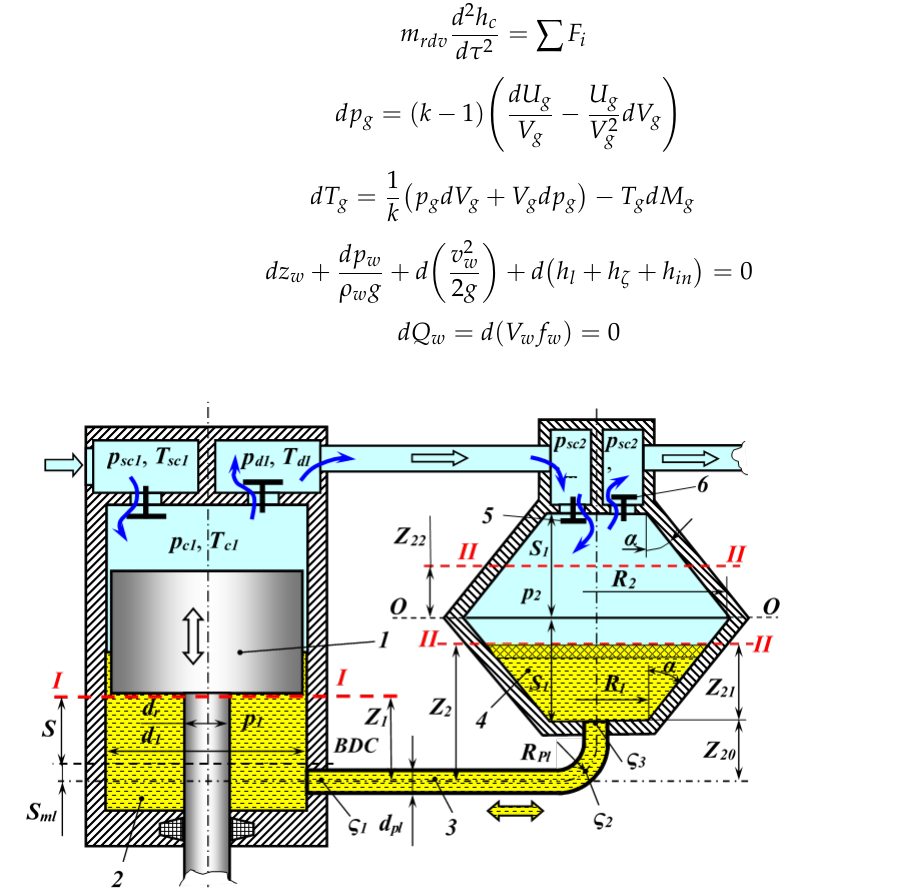
Figure 4. Schematic diagram of a two-stage PHPM with a profiled working chamber of stage 2. When determining the elementary amount of heat removed from the compressed The system of differential equations describing the change in the thermodynamic pa- rameters of gas in stage 2 of the PHPM and the motion of liquid includes: the first law of thermodynamics of a variable mass body for an open thermodynamic system; the equa- tion of conservation of mass, the dynamics of motion of the closure body of the self-acting valve, the equation of state for a compressible gas, as well as the equation of conservation